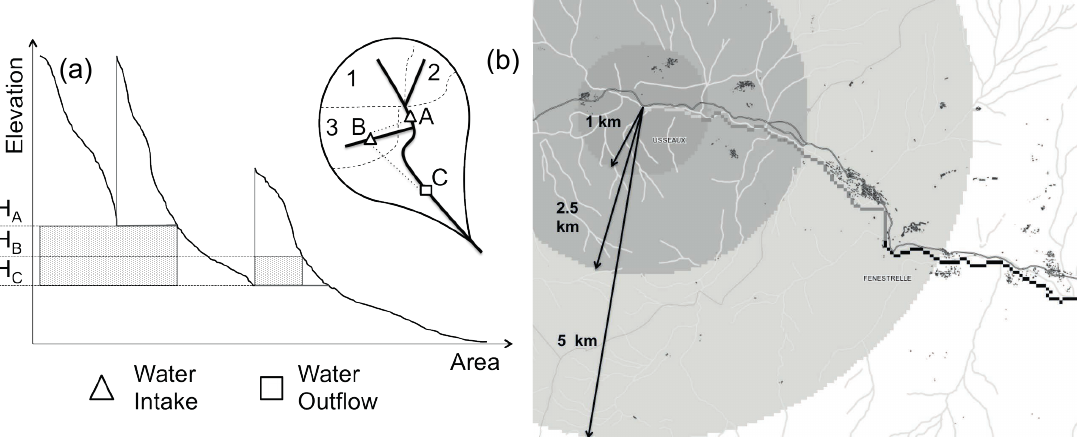
Fig. 3 (a) Classic Hydrodynamic Curve (HC). The grey area under the HC represents the hydrodynamic value that can be exploited by deriving in sections A and B and returning water in C. The different peaks represent contributions from the main-channel tributaries. (b) Polar metric and curvilinear circular windows for possible headrace extraction.